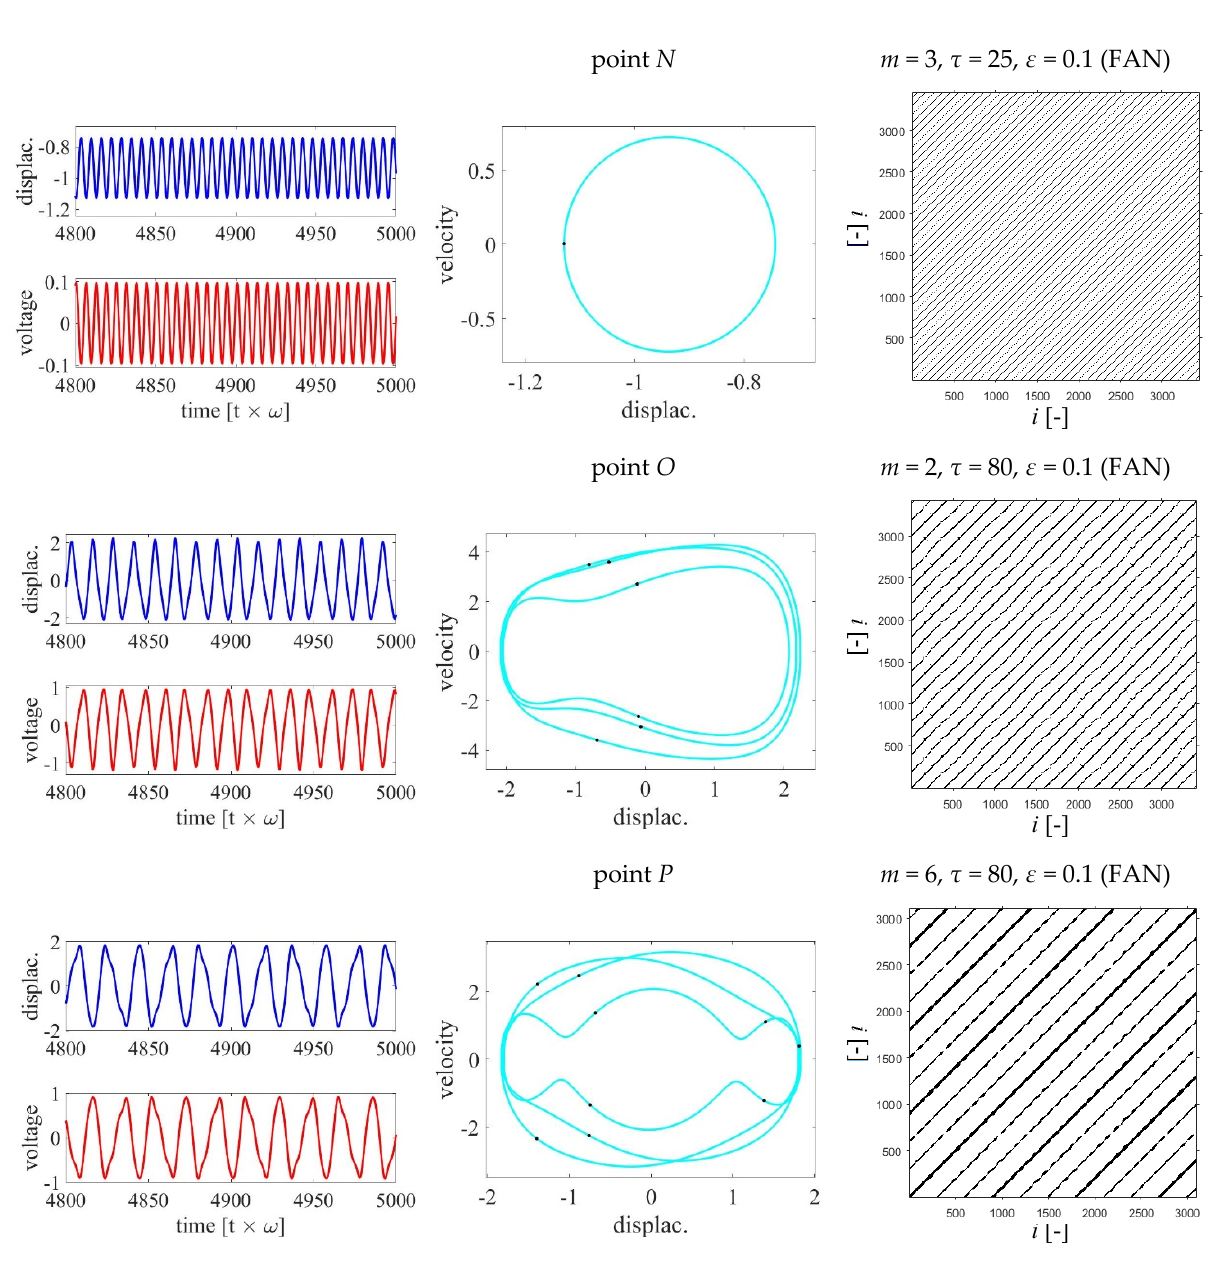
Figure 3. The detailed analysis results (points A – P ) of the cases are marked in Figure 2. In the left, center, and right panels, time series (displacement and voltage outputs), phase portrait with Poincaré points, and corresponding voltage RPs are presented. FAN in the recurrence plots indicates the fixed amount of nearest neighbors [22], which is the method of calibration of RPs with the same recurrence density.